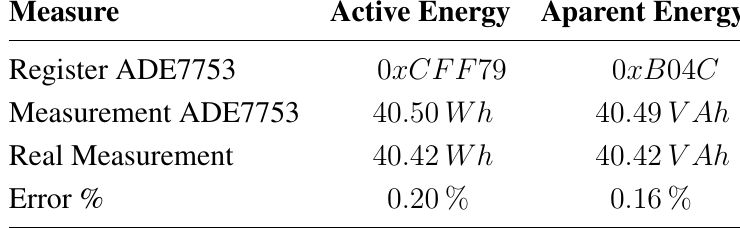
Table 2. Measurement of